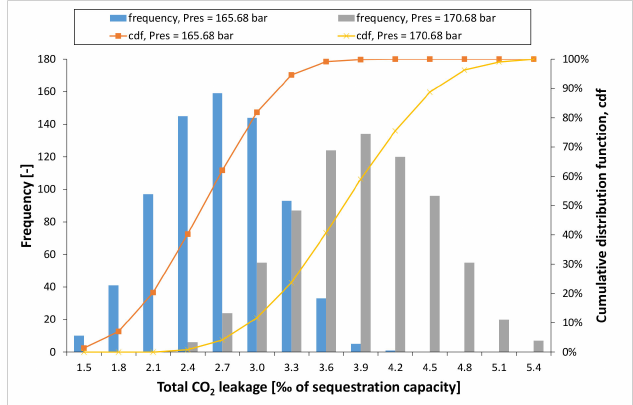
Figure 20. Histogram of the total CO 2 leakage to the overburden 500 years after the end of injection for Ensemble no. 1 (P ini1,s = 165.68 bar) and Ensemble no. 2 (P ini2,s = 170.68 bar).